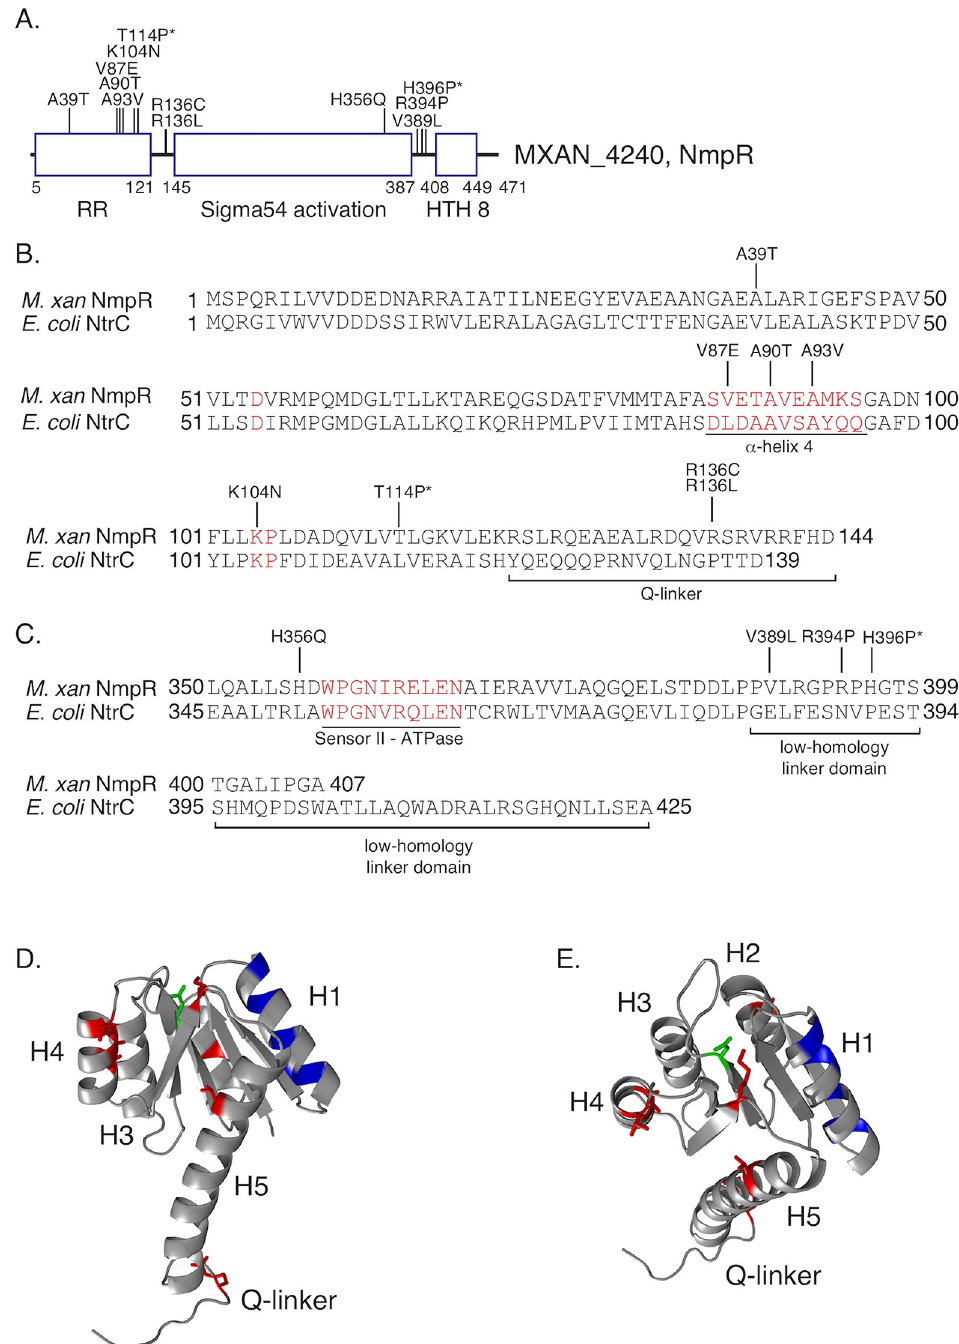
Fig 4. Additional gain-of-function suppressor mutations identified in nmpR . The M . xanthus Δ pilR strain was transformed with p High - nmpR , and suppressor mutants with restored motility were isolated and subjected to targeted sequencing of the over-expression construct. The identified mutations are indicated in a linear depiction of the NmpR domains (A), in the primary amino acid sequence of NmpR (B and C), or unbiasedly modeled on the ribbon structure of NtrX of Brucella abortus [51] with α -helices H1-H5 indicated (D and E). In panels B and C, the E . coli NtrC amino acid sequence is included for comparison and regions of interest in the protein sequence are indicated in red text and/ or underlined including: the α -helix 4 of the RR receiver domain, the nearly 100% conserved RR amino acid pair of KP at 104/105, the variable Q-linker, the sensor II motif necessary for ATPase activity, and the low-homology linker between the sigma54 activation domain and helix-turn-helix. Mutations indicated with a � were identified